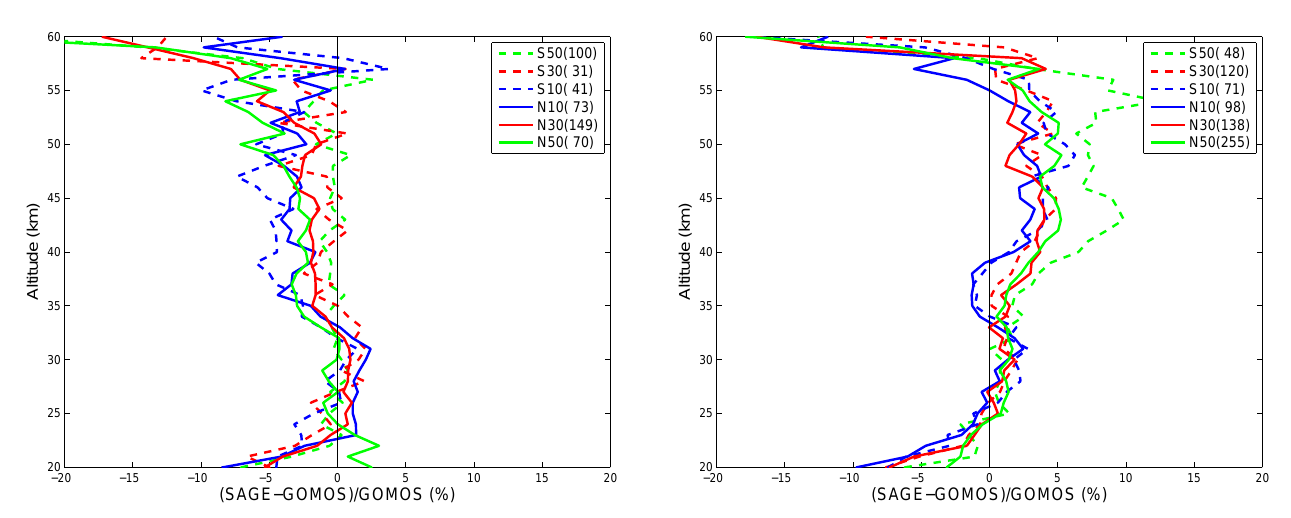
Fig. 7. The percent differences between SAGE II sunrise and GO- MOS nighttime measurements in 20 ◦ latitude bands. The line labels show the centers of the latitude bands and the number of colloca- tions.